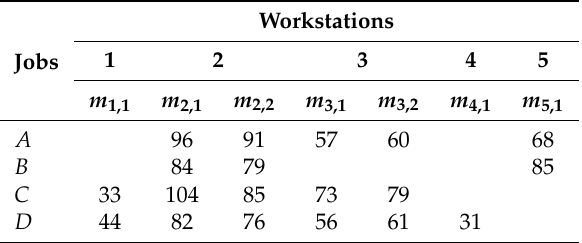
Table 1. Initially required workstations and processing times for the jobs in the demonstrative example.